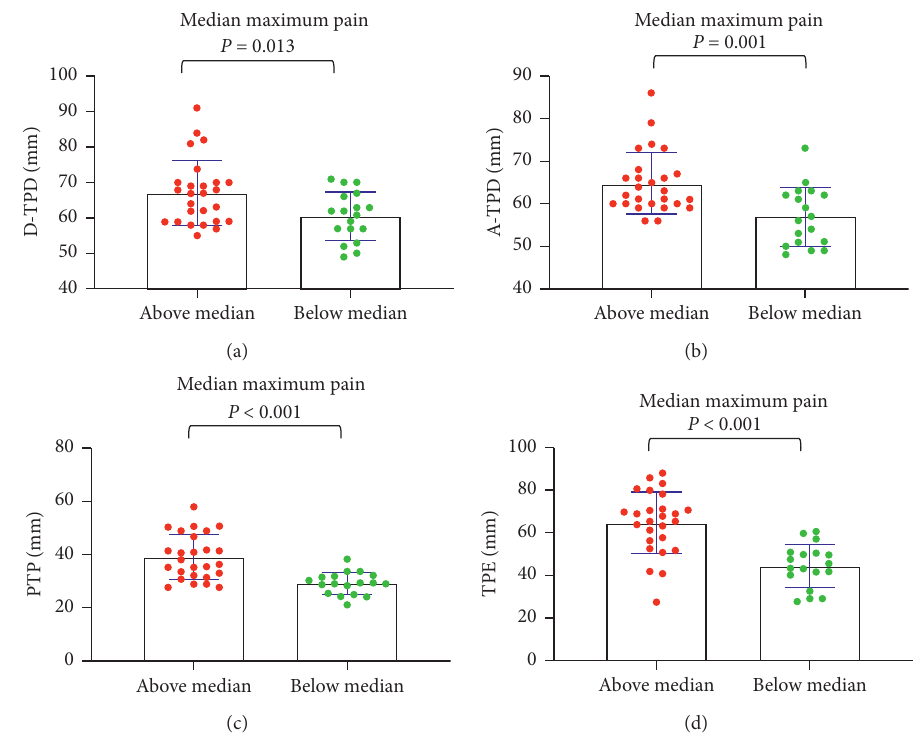
Figure 2: Tactile acuity for median maximum pain in the abovemedian group versus the belowmedian group. (a) D-TPD, (b) A-TPD, (c) PTP, and (d) TPE. The median of maximum pain was 5. D-TPD � two-point discrimination test performed in a descending manner; A-TPD � two-point discrimination test performed in an ascending manner; PTP � point-to-point test; TPE � two-point estimation.